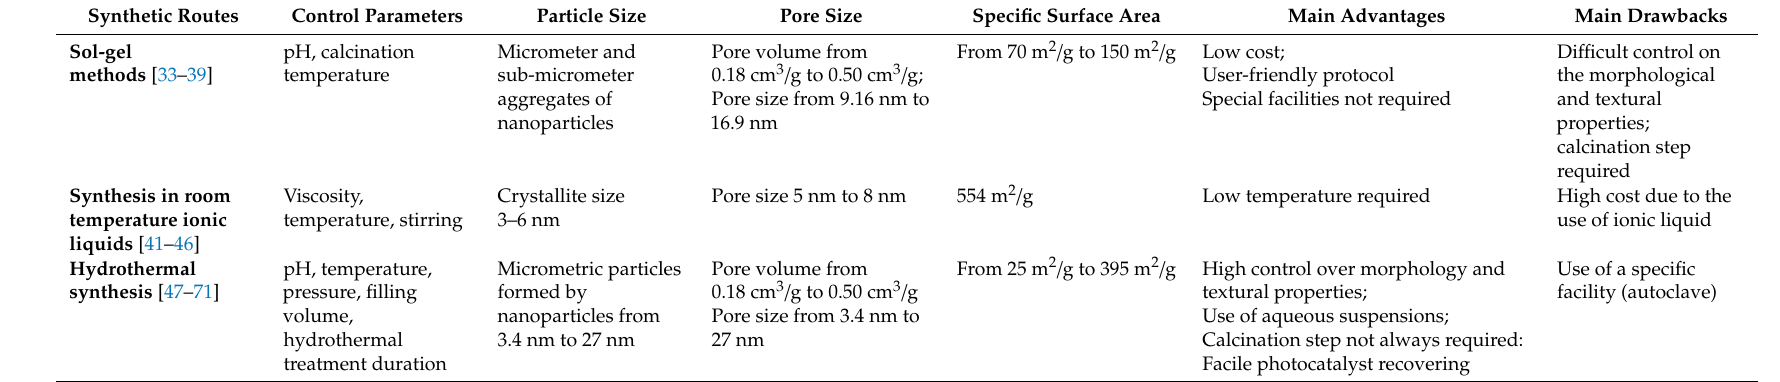
Table 1. Main characteristics of the reported synthetic approaches for the preparation of mesoporous TiO 2